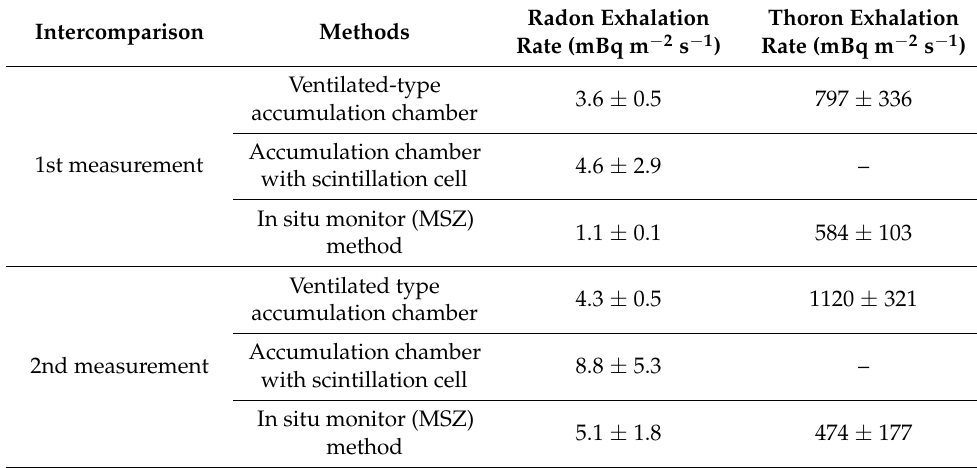
Table 1. Comparison of radon and thoron exhalation rates obtained by the ventilated-type accumula- tion chamber, accumulation chamber with scintillation cell, and in situ monitor (MSZ)